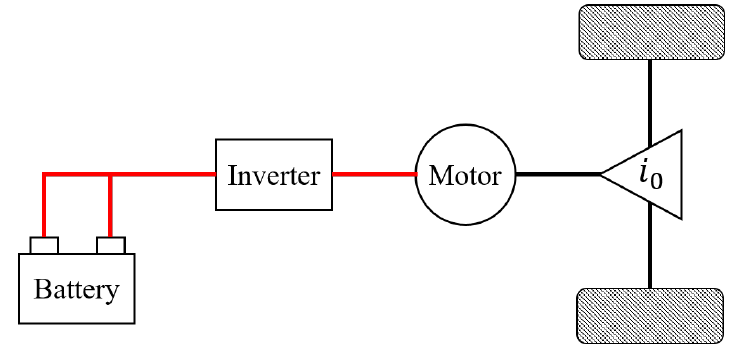
Figure 2. Schematic of a battery-electric